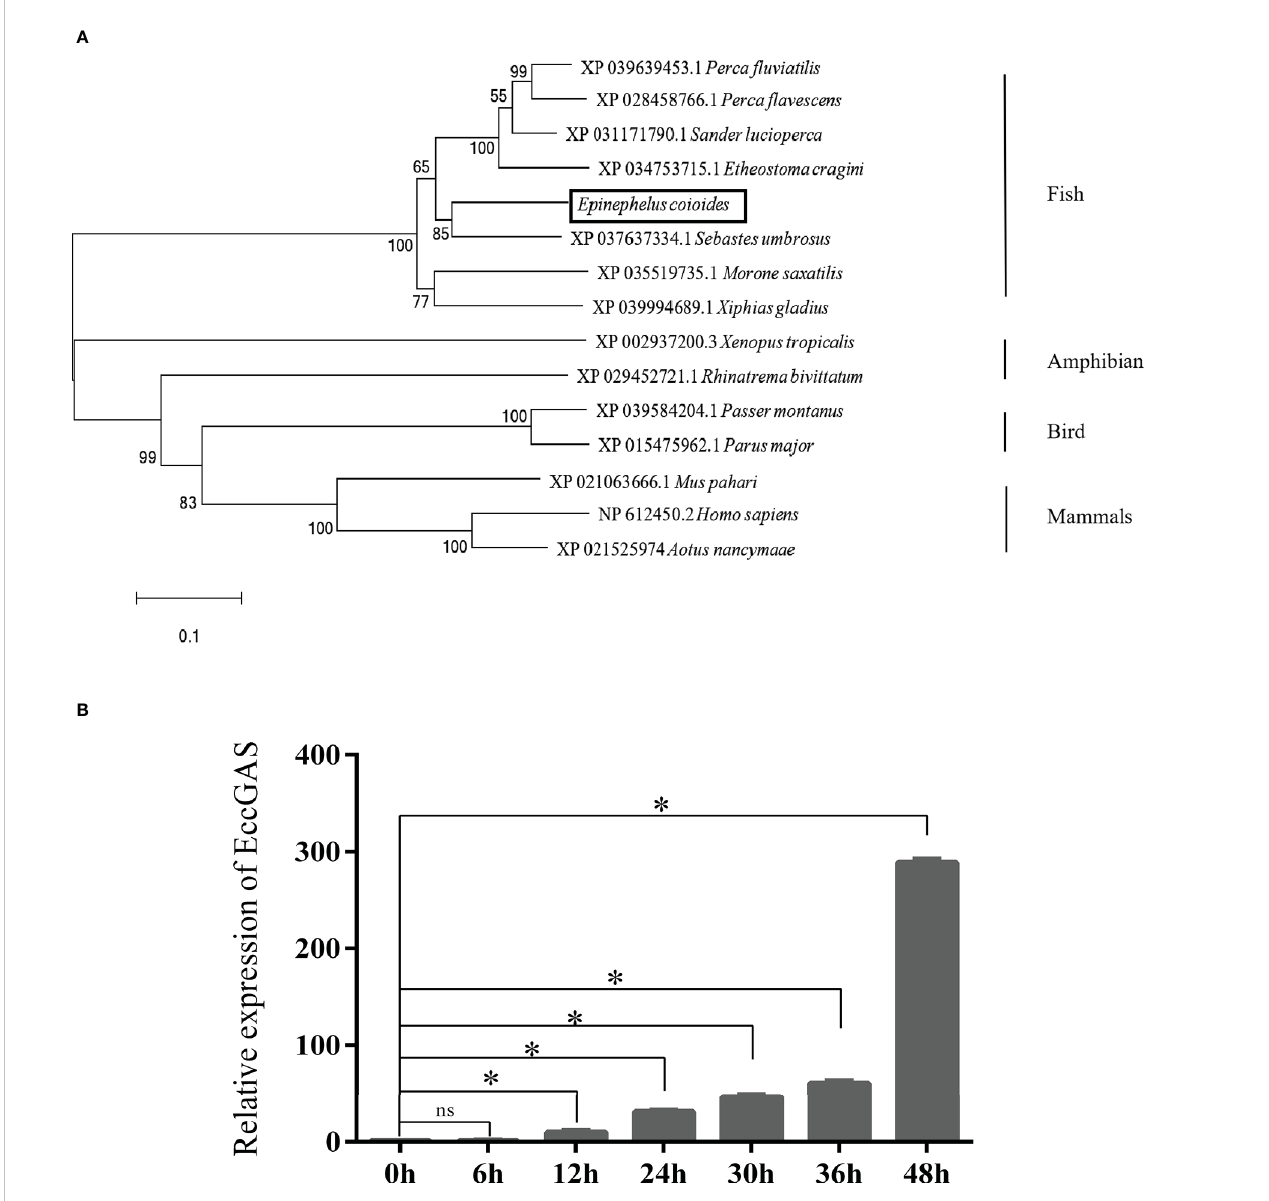
FIGURE 2 Expression pattern analysis of EccGAS. (A) Expression of EccGAS in different tissues of healthy groupers. Data were expressed as a ratio of the tissue value to the EccGAS mRNA expression in liver. b -actin were used as the internal control for the normalization across tissues. (B) Expression pro fi les of EccGAS in GS cells after SGIV infection. b -actin was used as an internal control. *P < 0.05. ns means no signi fi